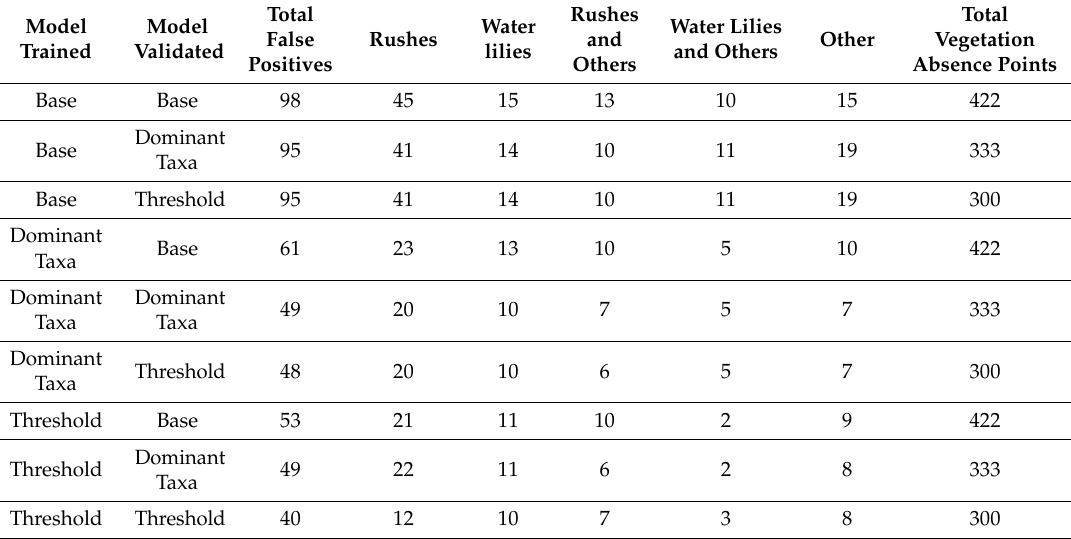
Table A3. False positive breakdown for each model validated on each validation